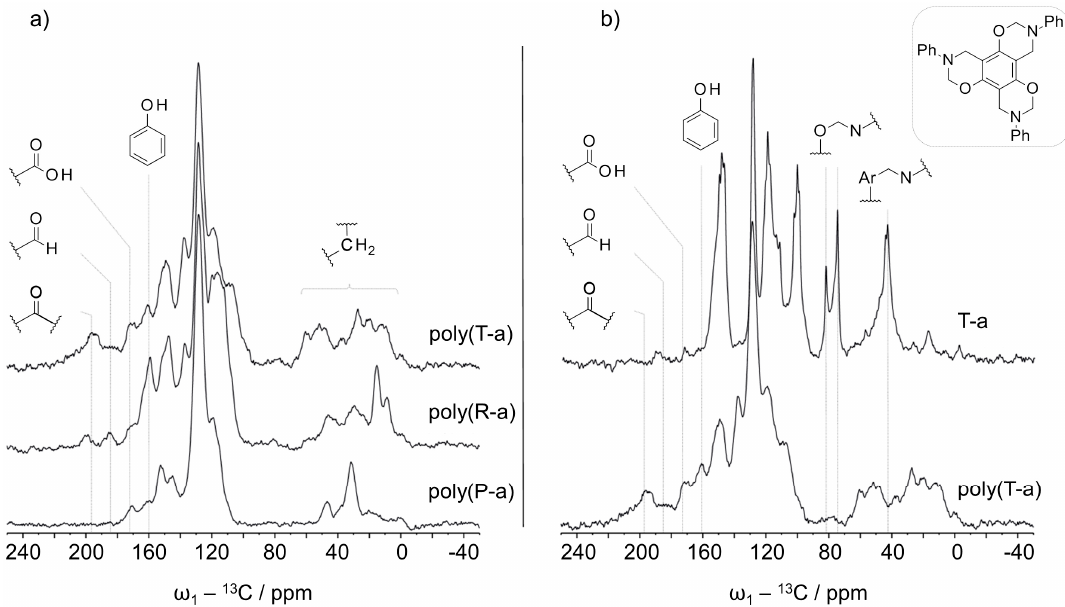
Figure 5. 13 C CP-TOSS experiments for: ( a ) polymers derived from P-a, R-a, and T-a and ( b ) comparison of T-a with poly T-a. All spectra were recorded under the same conditions (see experimental conditions).